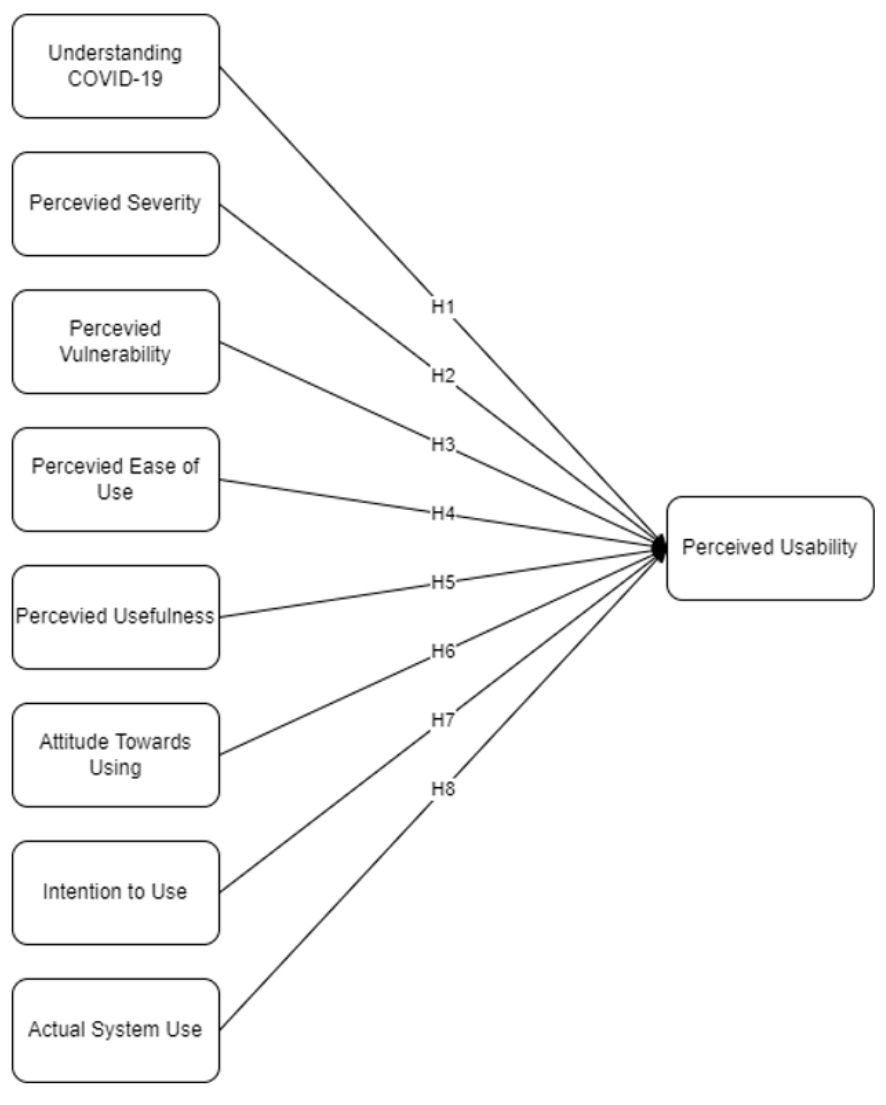
Figure 1. Theoretical Framework.